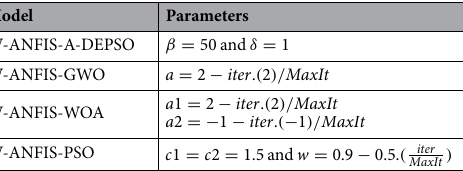
Table 12. Control parameters of the LSSVM, MARS, and GRNN